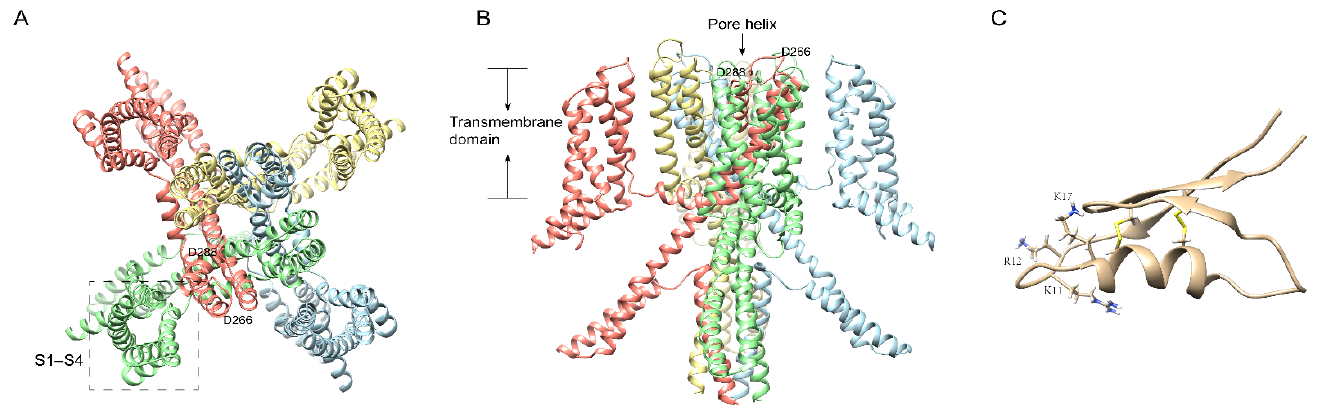
Figure 3. The cryo-electron microscopy (cryo-EM) structure of human KCNQ4 and SsTx. Ribbon diagram of KCNQ4 atomic model (PDB id: 7VNP) with each of the four identical subunits color- coded, showing views from the bottom ( A ) and side ( B ). The key residues for the interaction with SsTx are labeled. The membrane-spanning helices and different subunits of KCNQ4 channel are indicated. ( C ): SsTx from Scolopendra morsitans . PDB id: 5X0S.